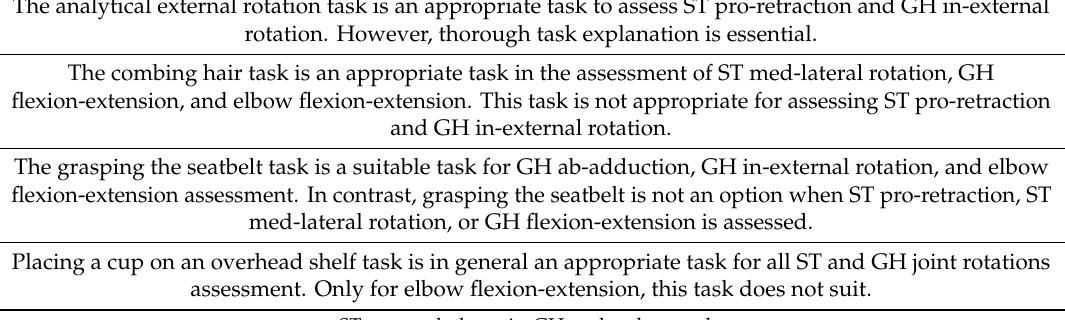
Table 6. Recommendations for parameter selection based on agreement and reliability